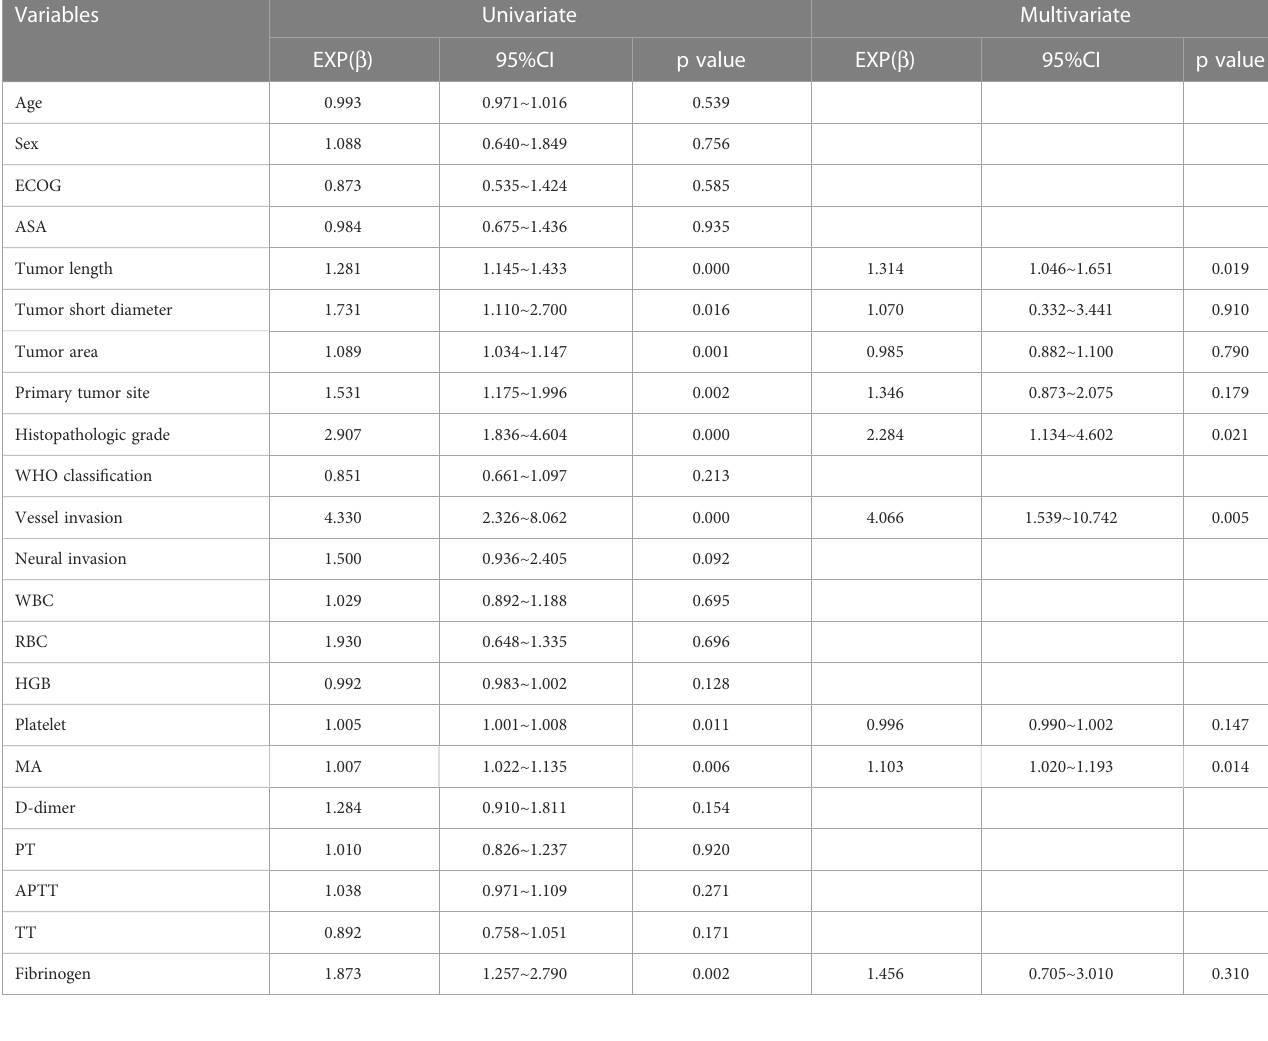
TABLE 4 In fl uencing factors of lymph node metastasis(N0/N+) in patients with gastric cancer.